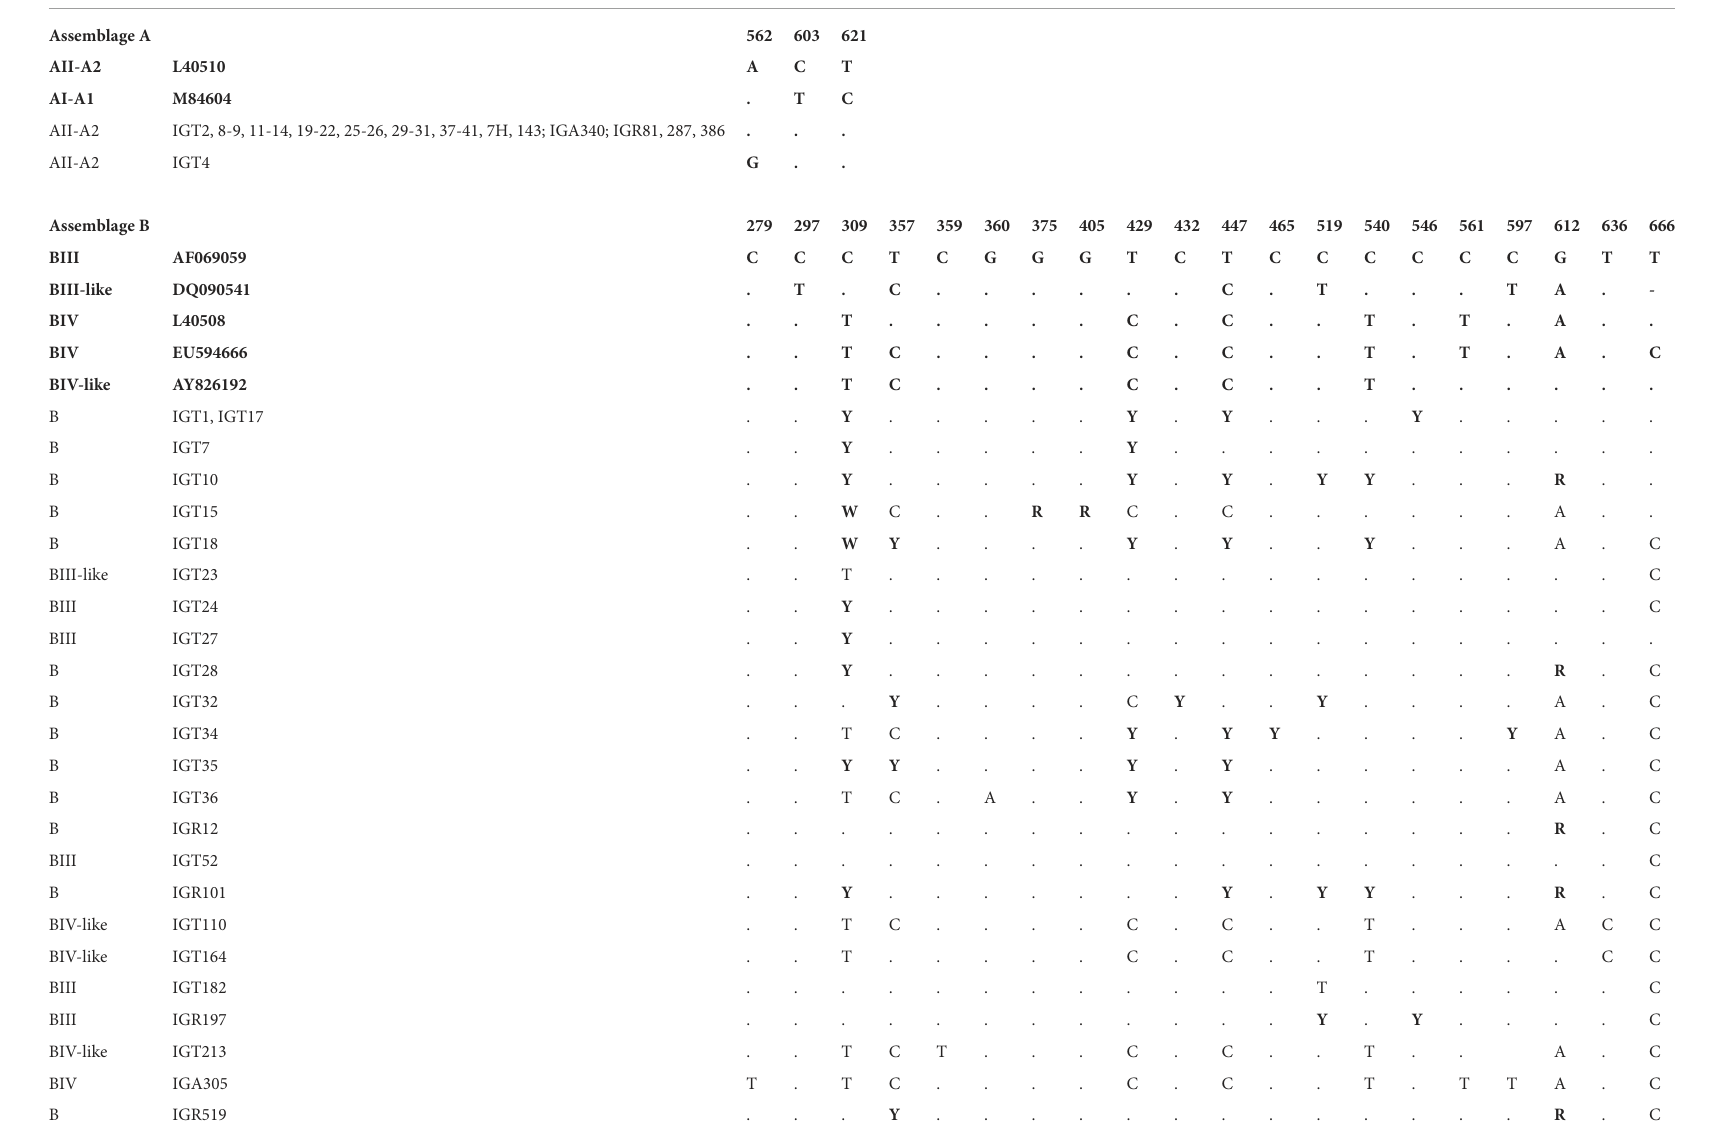
TABLE 6 Glutamate dehydrogenase ( gdh ) multiple alignment sequence isolates in this study with reference sequences retrieved from GenBank, representing the position of intra-genotypic substitutions in sub-assemblages of assemblages A and B. Isolates/GenBank accession